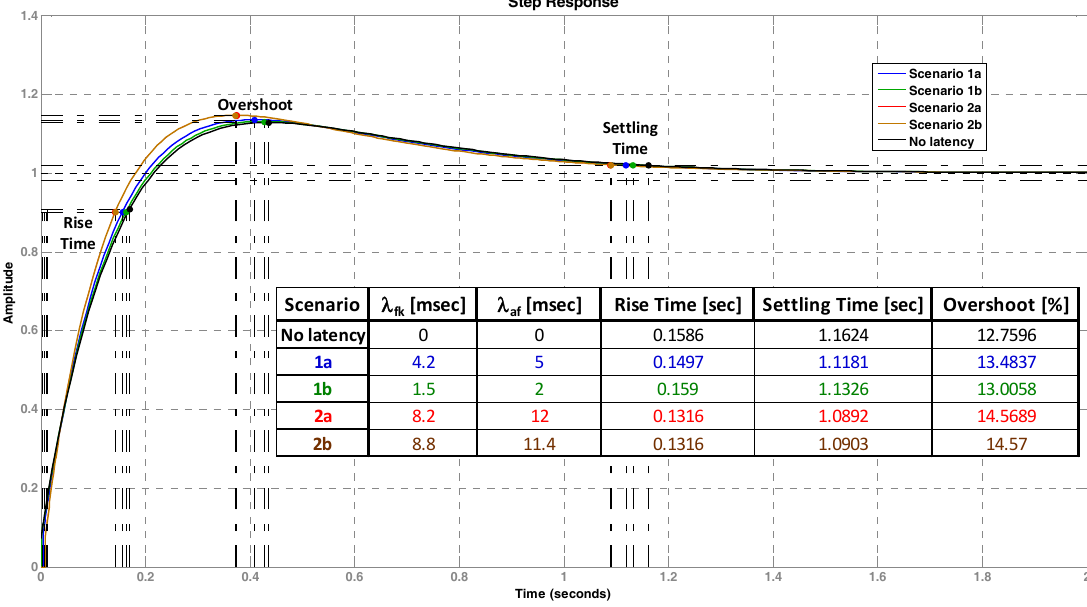
Figure 22. Time response for an input (desired level) for the mid pump.